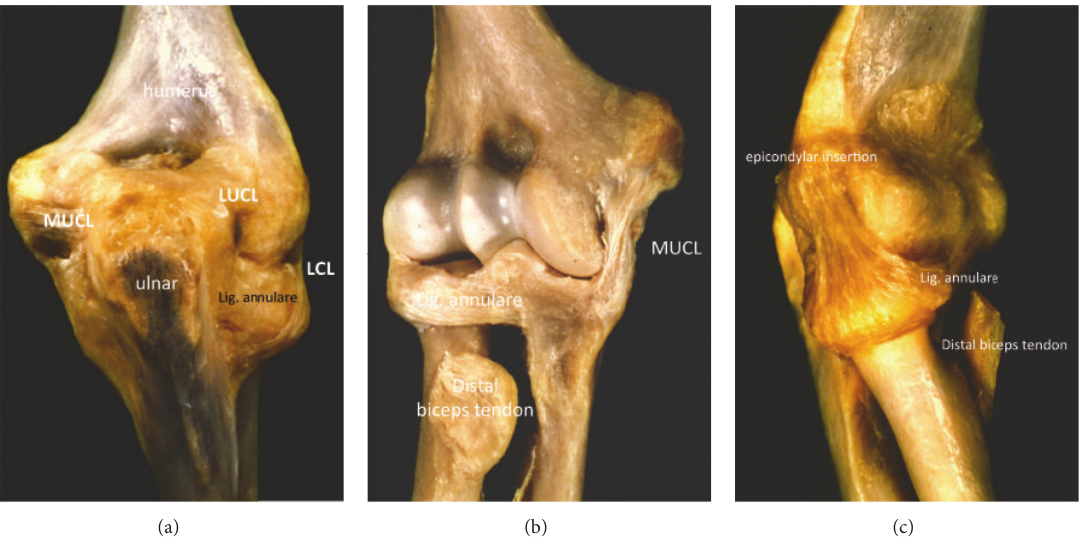
Figure 1: (a) Dorsal view to an anatomic elbow preparation. The posterior lateral ulnar collateral ligament (LUCL) and the posterior medial ulnar collateral ligament (MUCL) are visible. The posterior part of the ligamentum annulare with its insertion to the ulnar and the above lying distal part of the LCL can be seen. (b) Ventral view to an anatomic elbow preparation with demonstration of the anterior medial ulnar collateral ligament (aMUCL). The plane joint surface of the anteromedial facet of the olecranon can be seen, which has a buttress function in varus and valgus stress. (c) Lateral view to an anatomical elbow preparation with an illustration of the lateral collateral ligament complex (LCL) which is formed by the annular ring running to the radial epicondyle